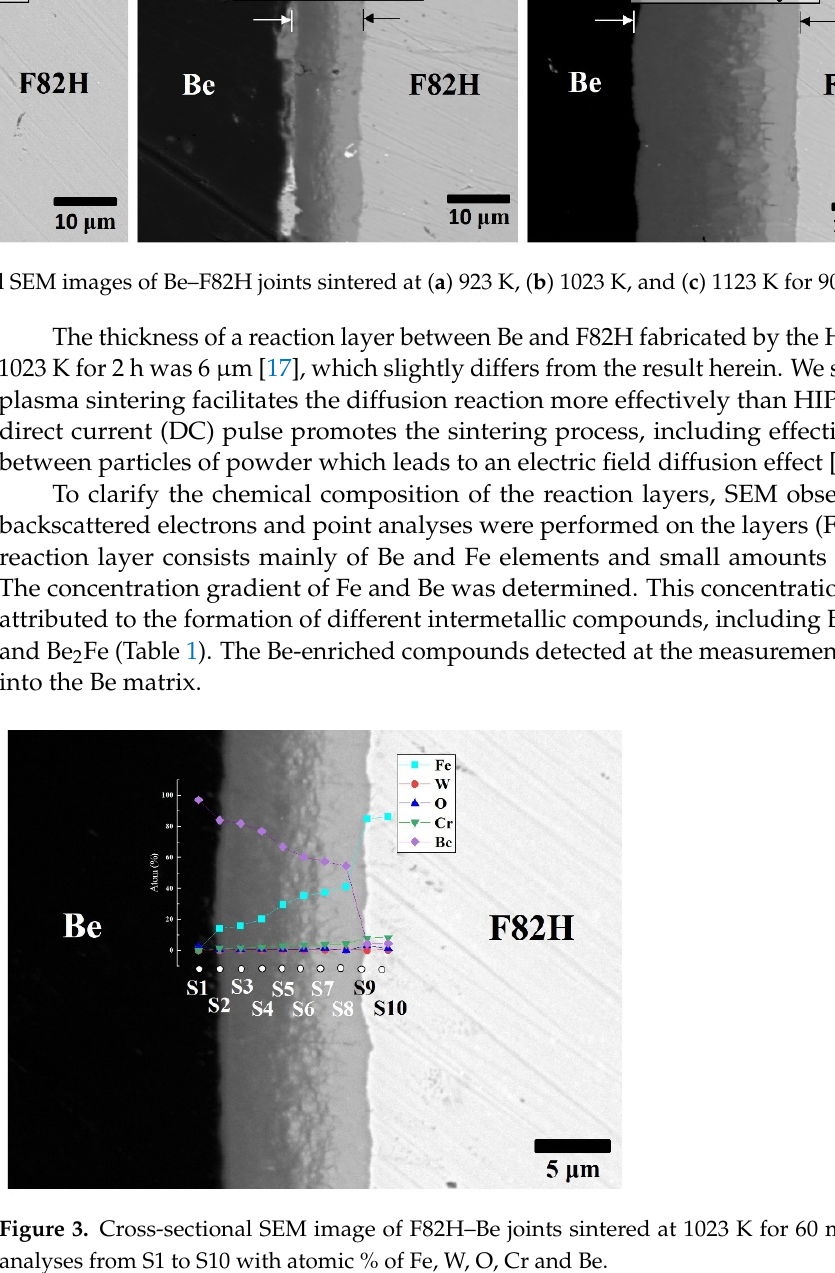
Figure 1. Cross-sectional SEM images of Be–F82H joints sintered at 1023 K for ( a ) 30 min, ( b ) 60 min, and ( c ) 90 min.